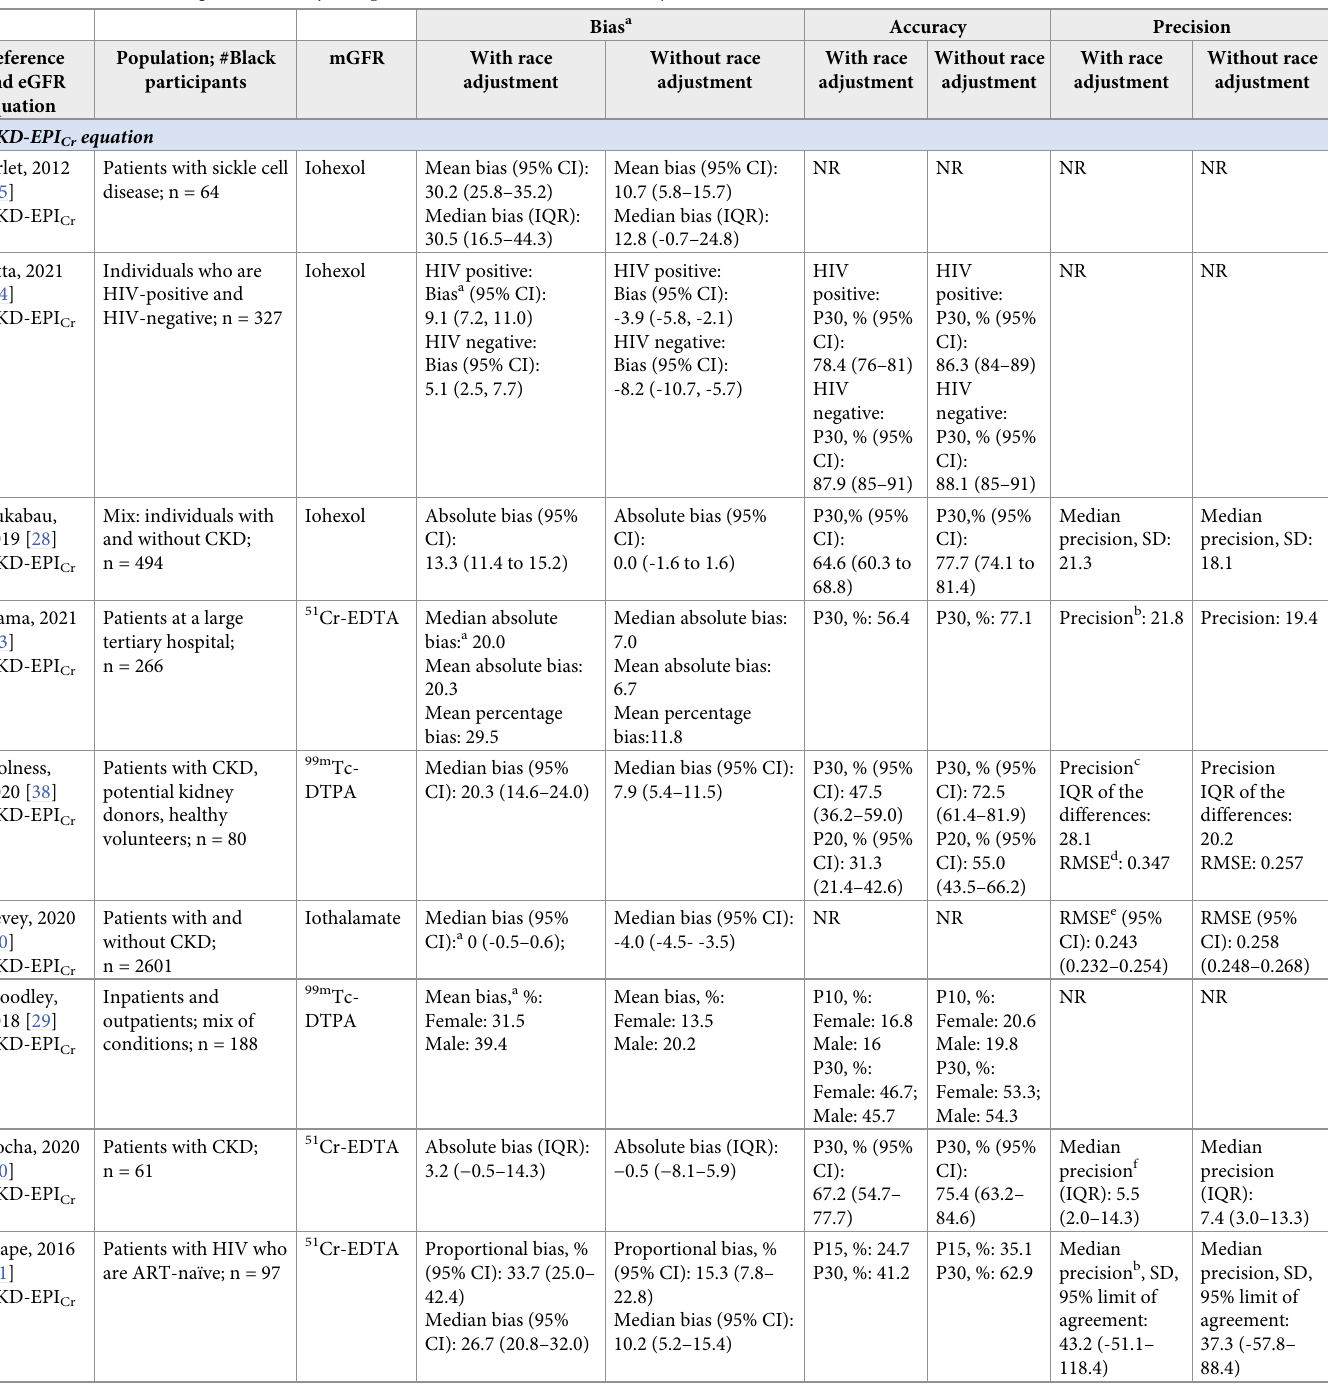
Table 2. Studies evaluating bias, accuracy, and precision, with and without race adjustment.